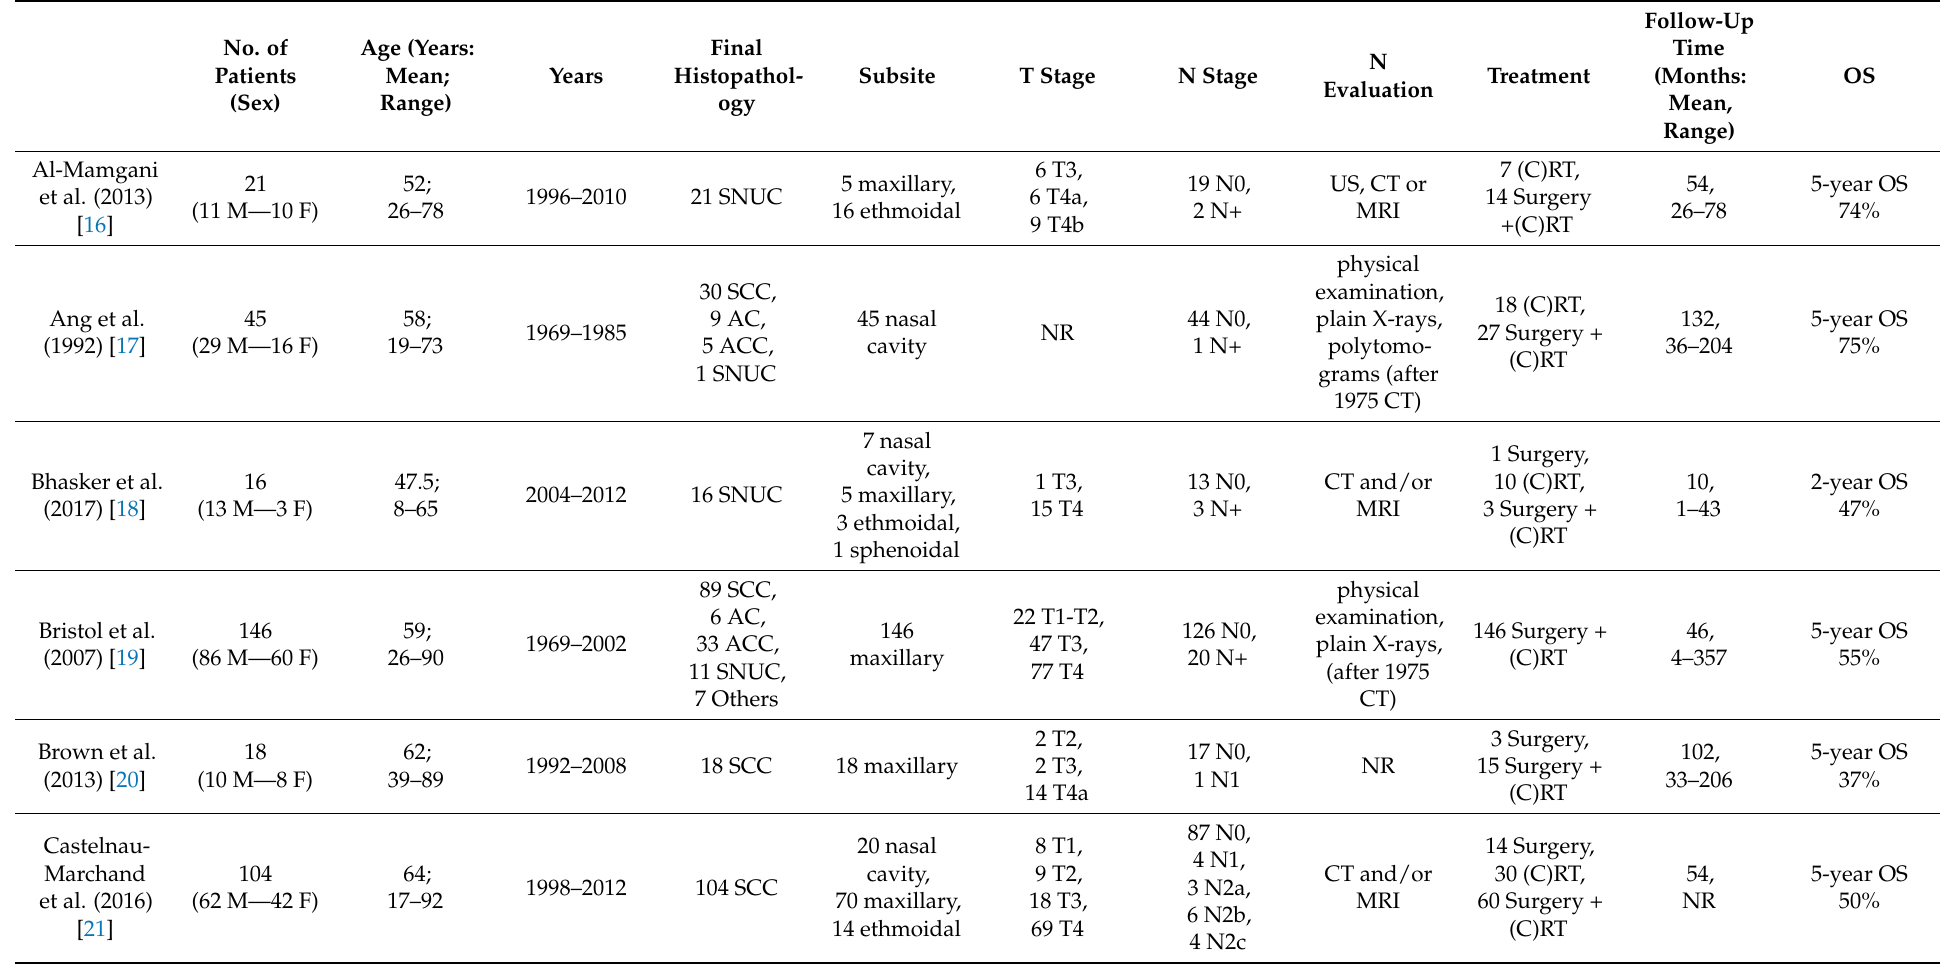
Table 1. A descriptive overview of the articles included in the meta-analysis. AC: adenocarcinoma; ACC: adenoid-cystic carcinoma; NR: not reported; SCC: squamous cell carcinoma; SNUC: sinonasal undifferentiated carcinoma; US: ultrasound; CT: computed tomography; MRI: magnetic resonance imaging; (C)RT: Radiotherapy +/ − chemotherapy; OS: overall